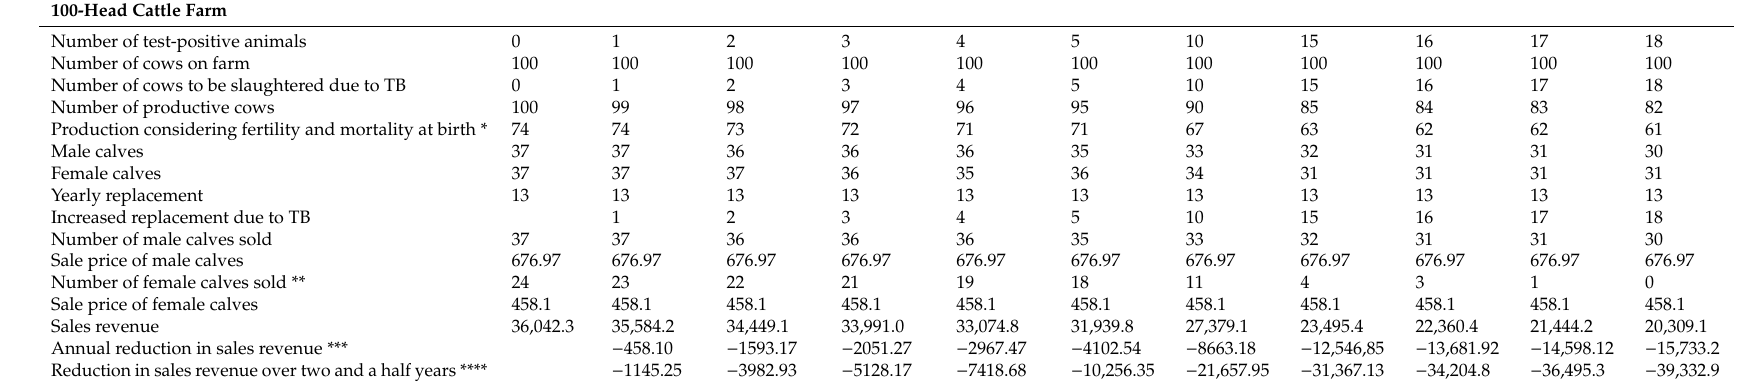
Table 7. Loss from replacement on a farm with 100 head of